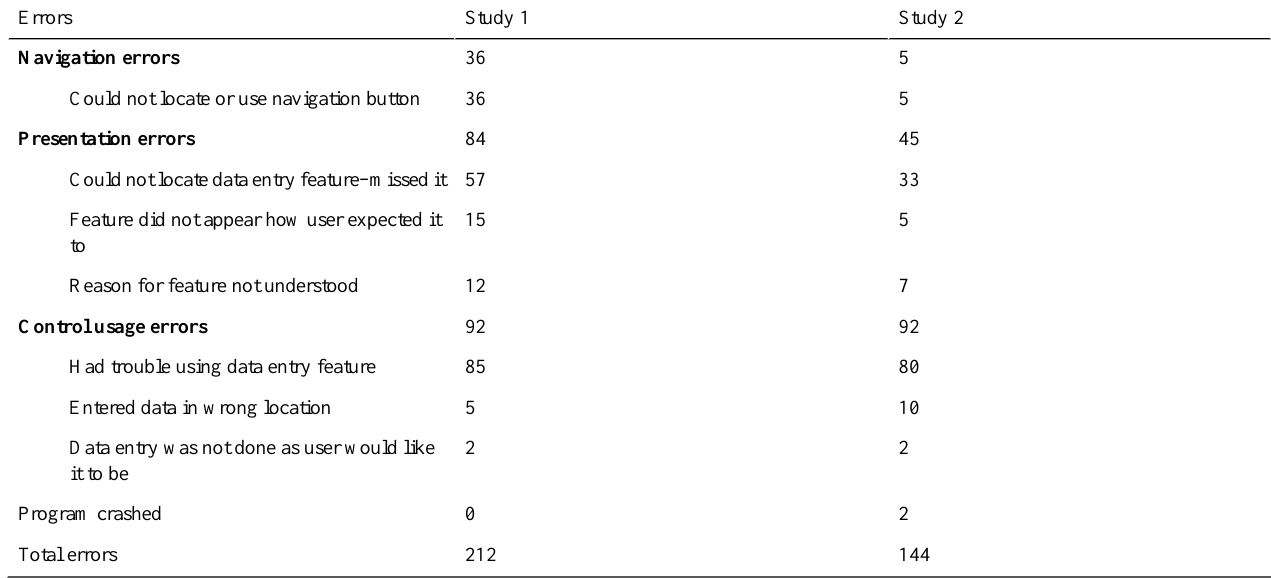
Table 1. Errors in Study 1 and Study 2: Navigation errors–failure to locate functions, excessive keystrokes to complete a function, failure to follow recommended screen flow; Presentation errors–failure to locate and properly act upon desired information in screens, selection errors due to labeling ambiguities; Control usage problems–improper entry field